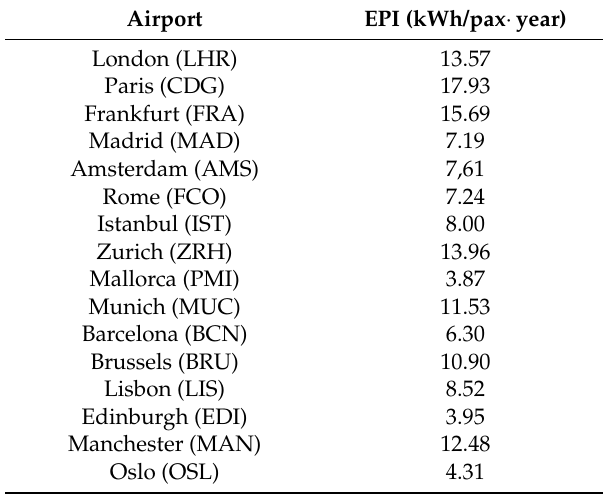
Table 4. Energy benchmarking in European airports in 2009. Source: